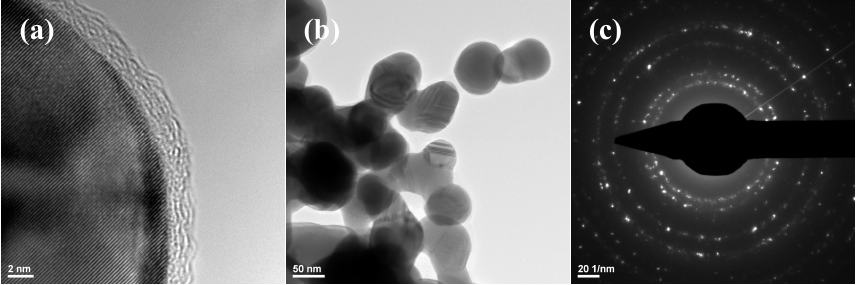
Figure 1. Transmission electron microscopy (TEM) images recorded for ( a , b ) silver nanoparticles (NanoAg) and selected area electron diffraction (SAED) pattern ( c ).